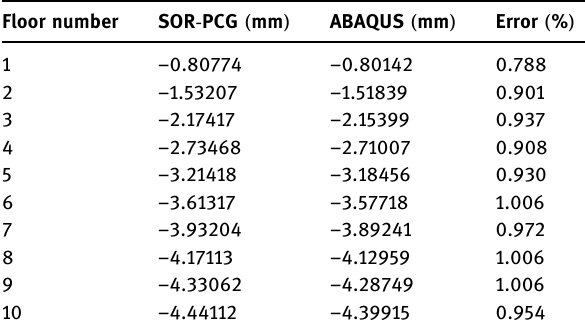
Figure 3: A heterogeneous platform design.